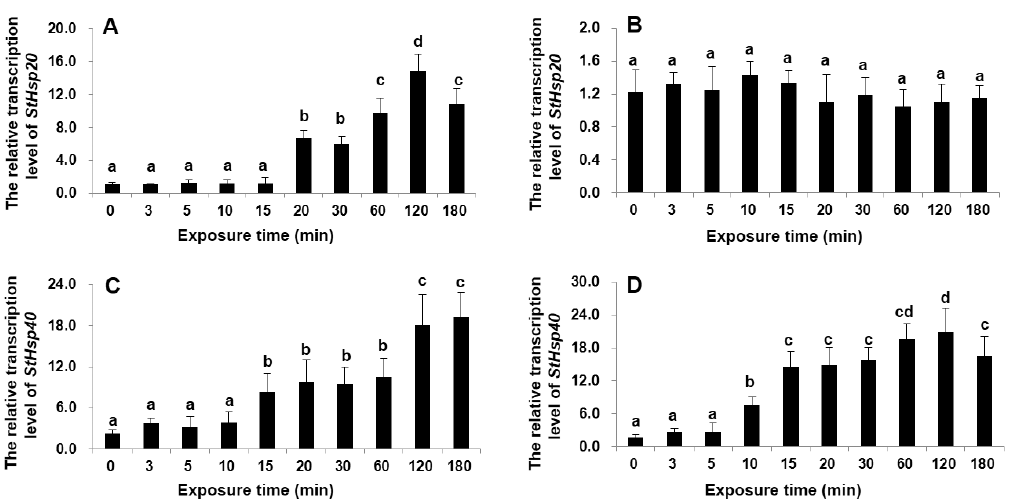
Figure 4. Transcription profiles of StHsp20 ( A , B ) and StHsp40 ( C , D ) in cells exposed to 30 °C ( A , C ) and 10 °C ( B , D ) with durations from 3 to 180 min. Different letters show significant differences ( p < 0.05). Error bars represent the standard deviation from 3 replicates.